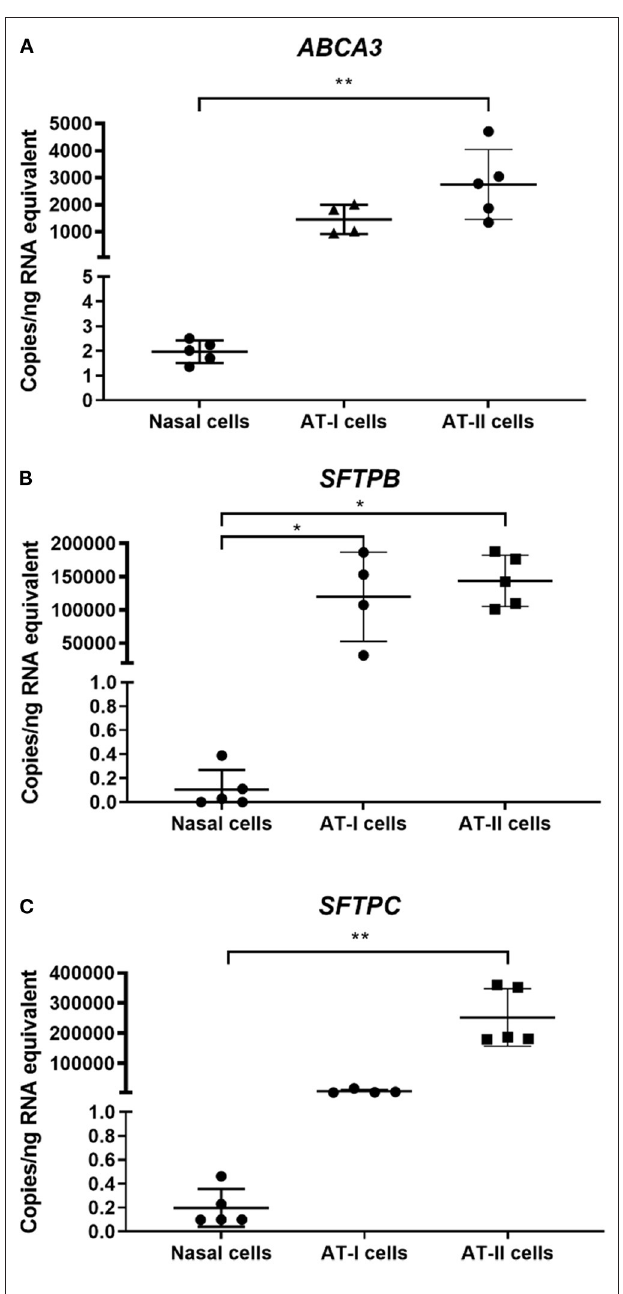
FIGURE 1 | Gene expression in primary nasal cells. Concentration of target mRNA for ABCA3 (A) , SFTPB (B) , SFTPC (C) in primary nasal cells ( n = 5), AT-I cells ( n = 4), and AT-II cells ( n = 5) was determined by ddPCR and expressed as copies/ng of RNA equivalent. The expression of ABCA3 was significantly lower in primary nasal cells compared to AT-II cells ( p = 0.003). The expression of SFTPB was significantly lower in primary nasal cells compared to AT-I cells ( p = 0.041) and AT-II cells ( p = 0.010) while the expression of SFTPC in primary nasal cells was significantly lower compared to AT-II cells ( p = 0.001). AT-I cells, AT-I cells; AT-II cells, AT-II cells; * p < 0.05; ** p < 0.01.